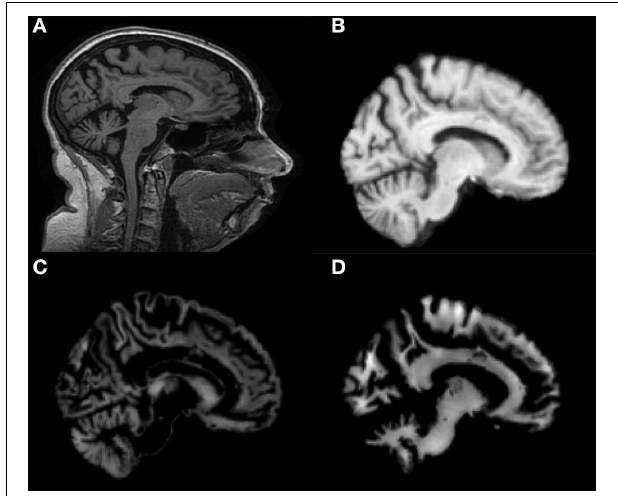
FIGURE 1 | Sagittal image of a MR scan from a MCIc patient: (A) original image; (B) same slice, deskulled and co-registered to the MNI space; same slice, segmented into Gray Matter (GM) (C) and into White Matter (WM)